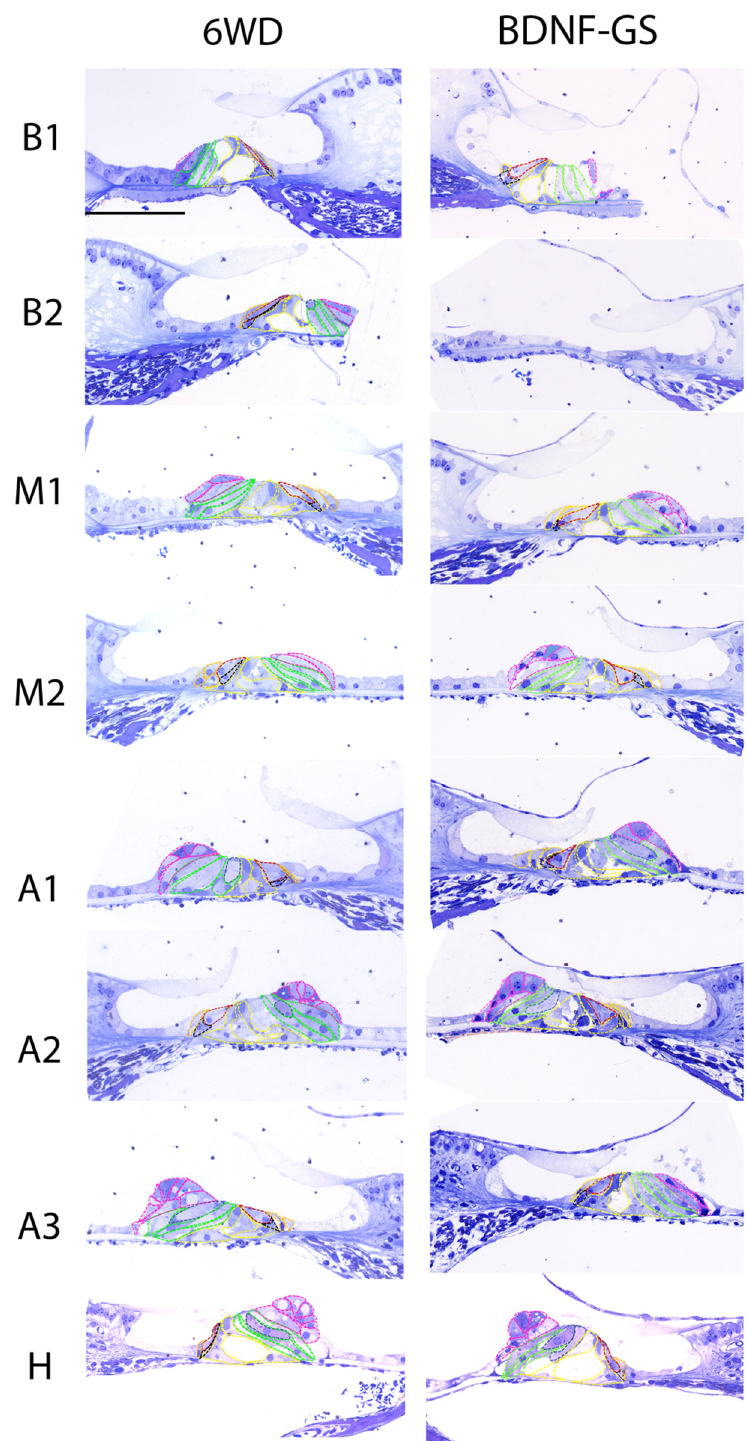
Figure 4. Representative images of the organ of Corti from BDNF-treated animals through gelatin sponge. Microscope images are representative of the organ of Corti of untreated (six weeks deaf: 6WD) ( left ) and BDNF-GS-treated cochleas (BDNF-GS) ( right ) of all cochlear locations: B1, B2, M1, M2, A1, A2, A3, H. Hair cells and supporting cells were marked by using a color coding: outer hair cells (blue), inner hair cells (red), border (orange), phalangeal (black), pillar (yellow), Deiters’ (green), and Hensen’s (pink). Scale bar: 50 µm.